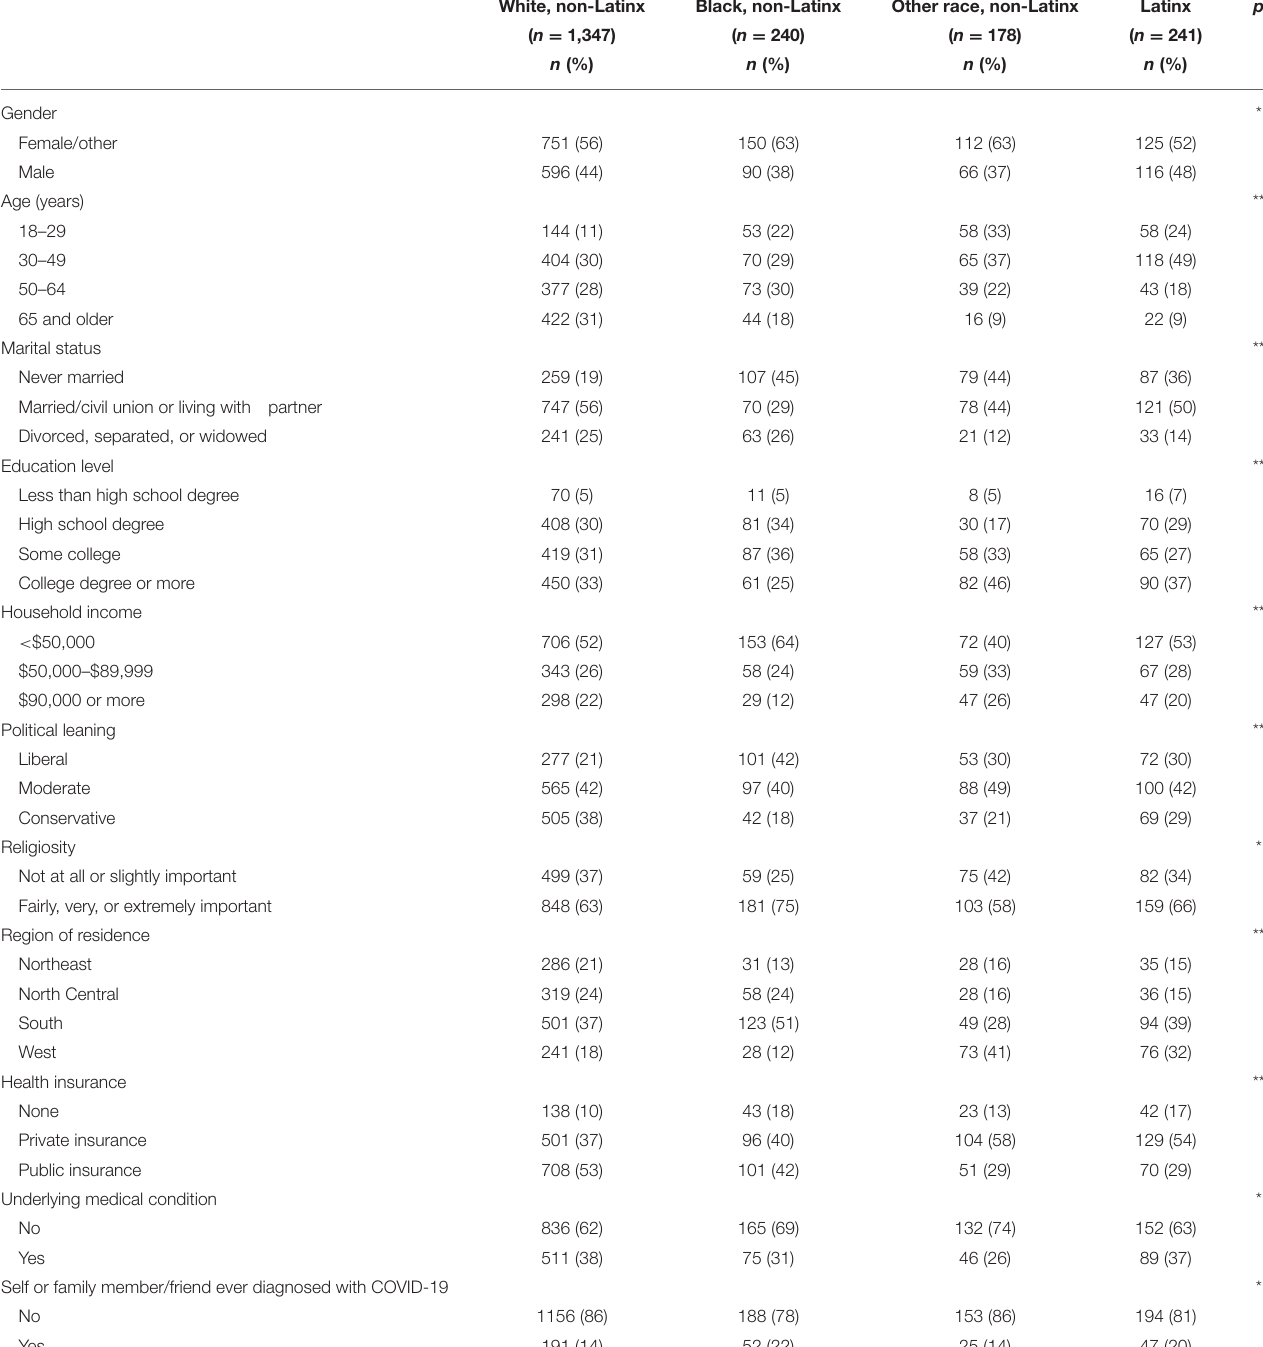
TABLE 1 | Demographic and health-related characteristics of participants by racial/ethnic group ( n = 2,006). White, non-Latinx Black, non-Latinx Other race,